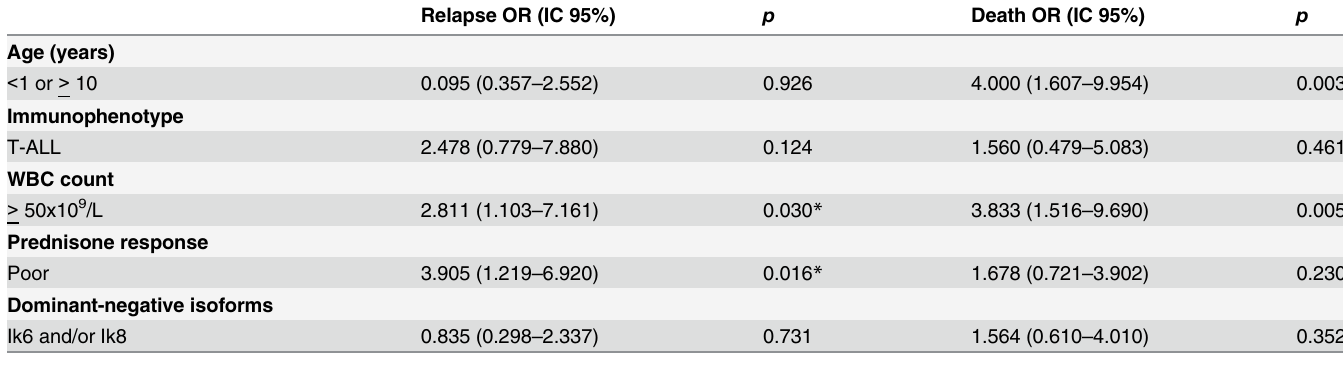
Table 3. Risk analysis for clinical-biological characteristics and dominant-negative Ikaros isoforms